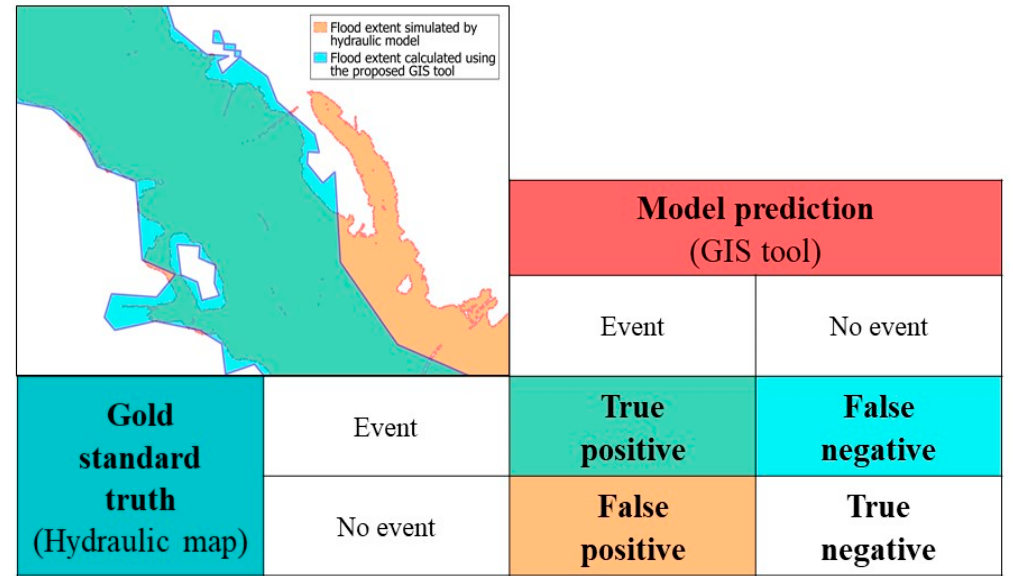
Figure 5. Schematic representation of the contingency table adopted to test the performance of the Geographic Information System (GIS)-tool in terms of dam-break flood extent map.